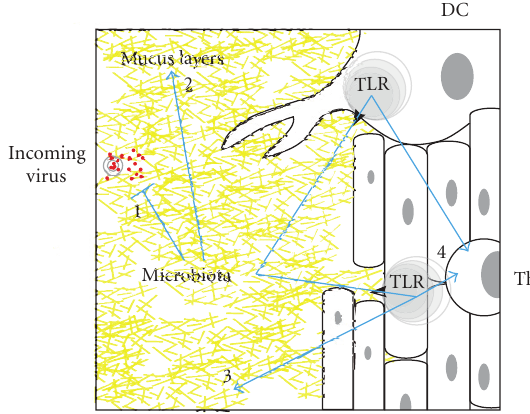
Figure 3: The microbiological context of HIV resistance. Vaginal microbiology influences susceptibility of the mucosal layer to HIV infection in multiple interrelated ways, including (1) direct e ff ects on viral particles or infected allogenic cells via binding, mannose scavenging, or bacterial metabolites (acid, H 2 O 2 ), (2) alteration of quantity/viscosity/permeability of mucin network in mucus layer via proteases, (3) stimulation of innate mucosal defence molecules and cells via TLR stimulation, and (4) modulation of T-cell activation and susceptibility via conditioning by TLR-stimulated dendritic cells, macrophages, or epithelial